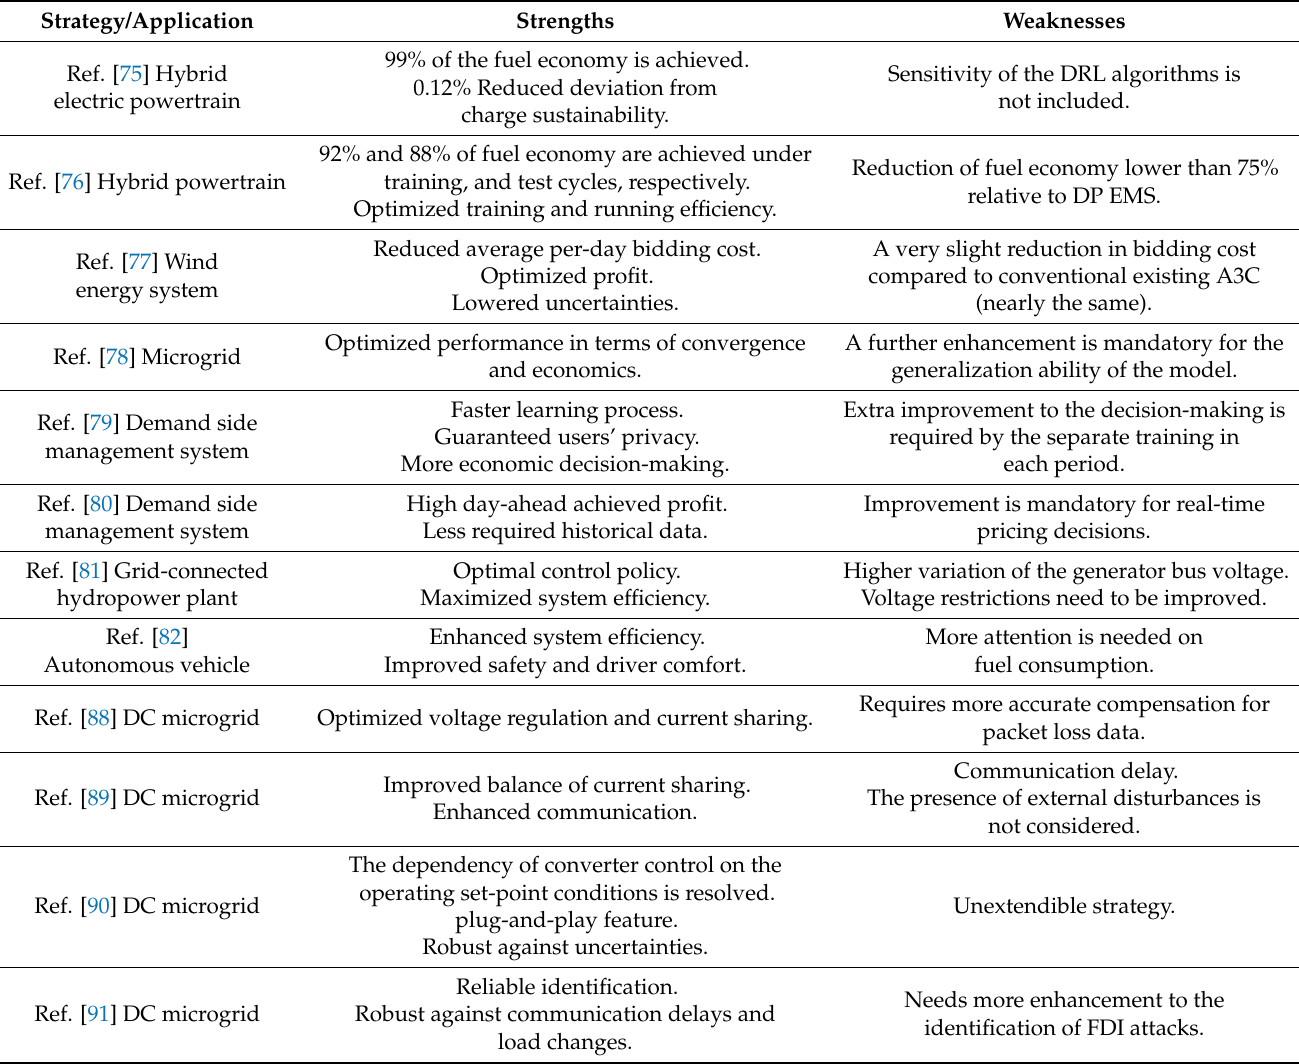
Table 2. Summary of the emerging advanced RL-based solutions of power flow management problems.